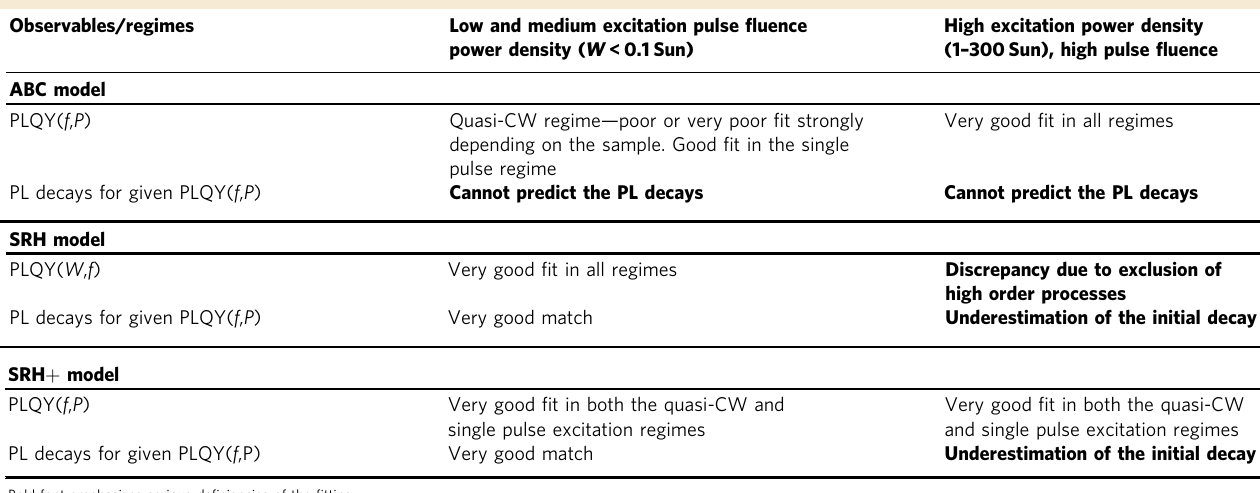
Table 1 Comparison of the ability of the three models to describe the PLQY( f , P ) maps and PL decays.